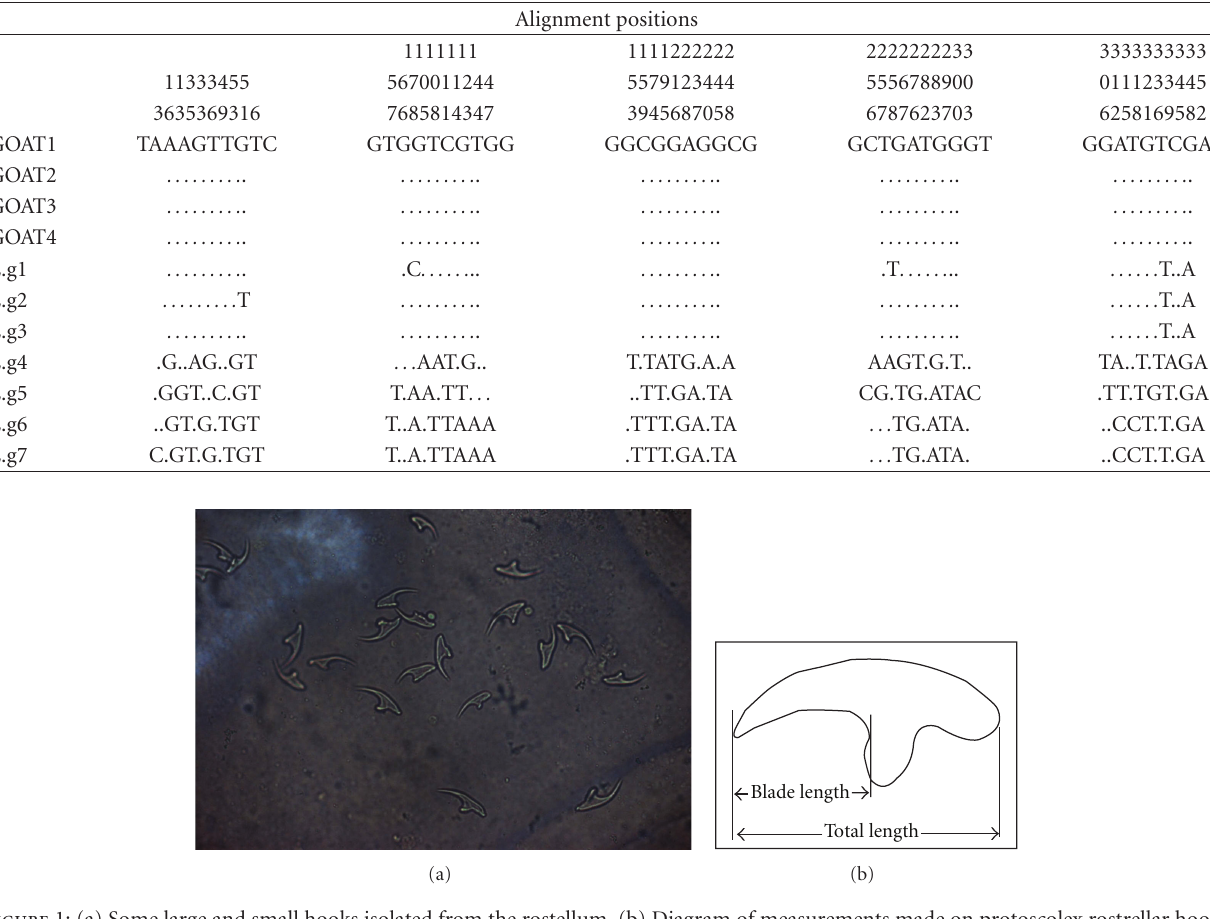
Figure 1: (a) Some large and small hooks isolated from the rostellum. (b) Diagram of measurements made on protoscolex rostrellar hooks (from